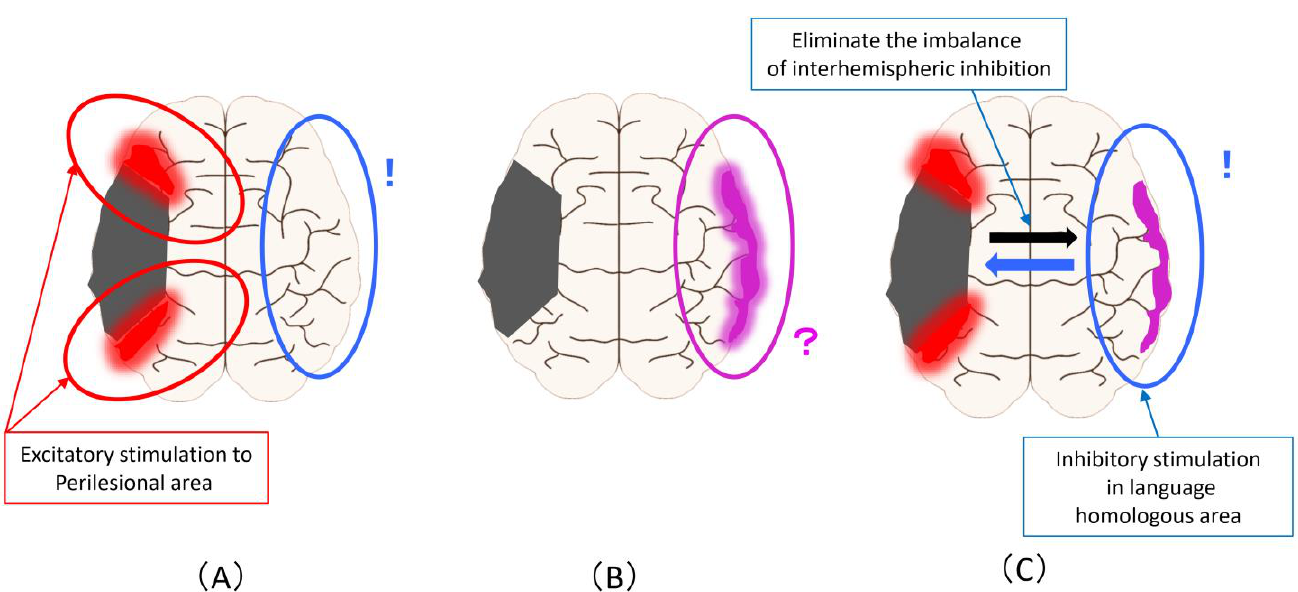
Figure 3. Magnetic stimulation site that can be assumed from the improvement mechanism related to language function in PSA: ( A ) Excitatory stimulation of the ipsilesional areas to promote compensatory activation in the perilesional areas (Red circle). the inhibitory stimulation to the language homologous areas based on the principle of interhemispheric inhibition (Blue circle); ( B ) Regarding the increase in activity in the homologous areas of the language domain, the stimulation site and stimulation methods are unclear (Pink circle); ( C ) An inhibitory stimulation to the language homology areas that eliminates the imbalance of interhe-mispheric inhibition and reduce the activity of the language homology areas (Blue circle).